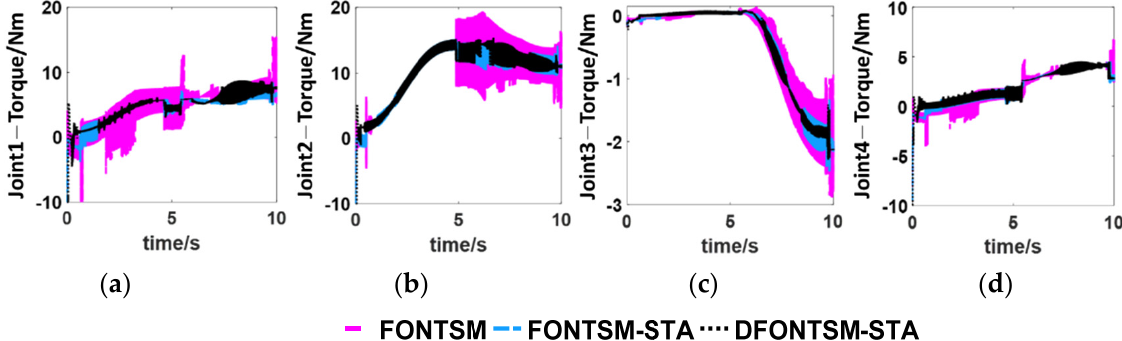
Figure 4. Control input torque of each joint ( a ): joint one; ( b ): joint two; ( c ): joint three; ( d ): joint four.